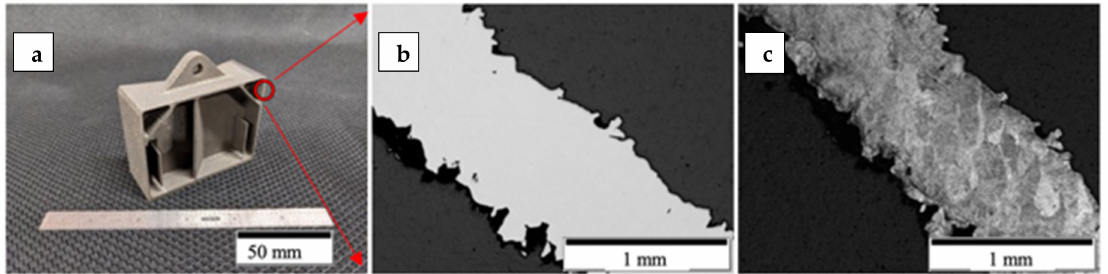
Figure 5. Sectioned printed part. ( a ) Sectioned electronic box enclosure at the red circle. ( b ) Polished micrograph. ( c ) Etched